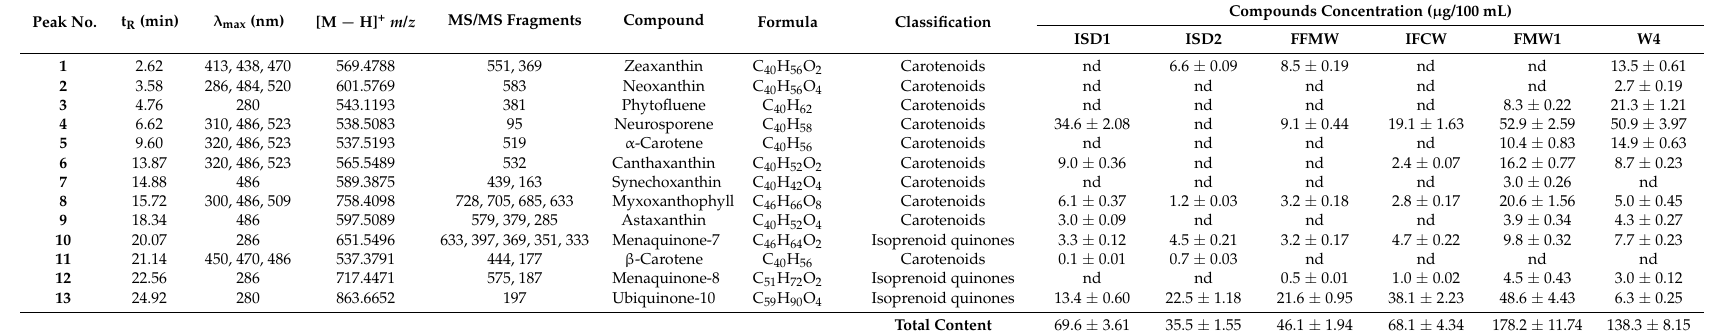
Table 1. Identification of carotenoids and other secondary metabolites from Asaia bogorensis (ISD1, ISD2 and FFMW) and Asaia lannensis (IFCW, FMW1 and W4) based on ultrahigh-performance liquid chromatography (UHPLC), retention time (t R ), UV–vis spectroscopic characteristics ( λ max ), and MS/MS spectroscopic pattern. Values are means of three determinations ± standard deviation. Concentration reported as µ g per 100 mL of culture medium. nd—not detected. Peak No. t R